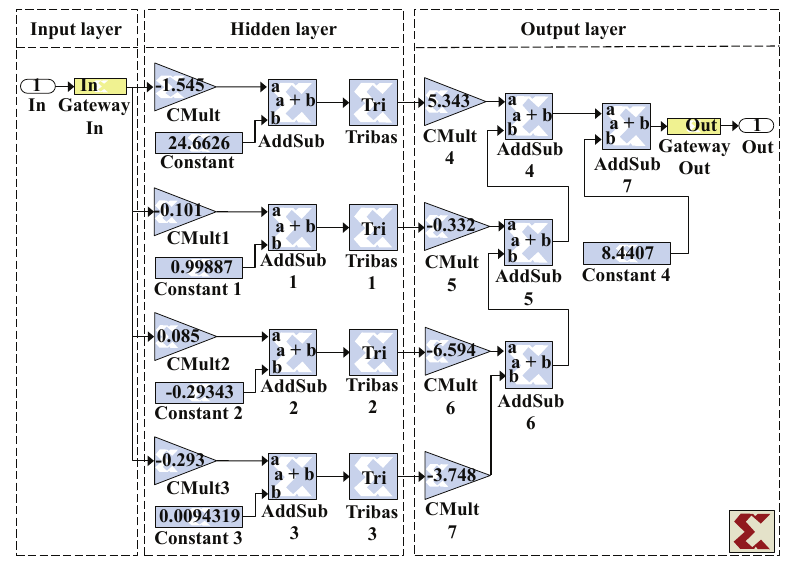
Figure 6. Implementation for NN AM/AM TWTA pre-distorter.